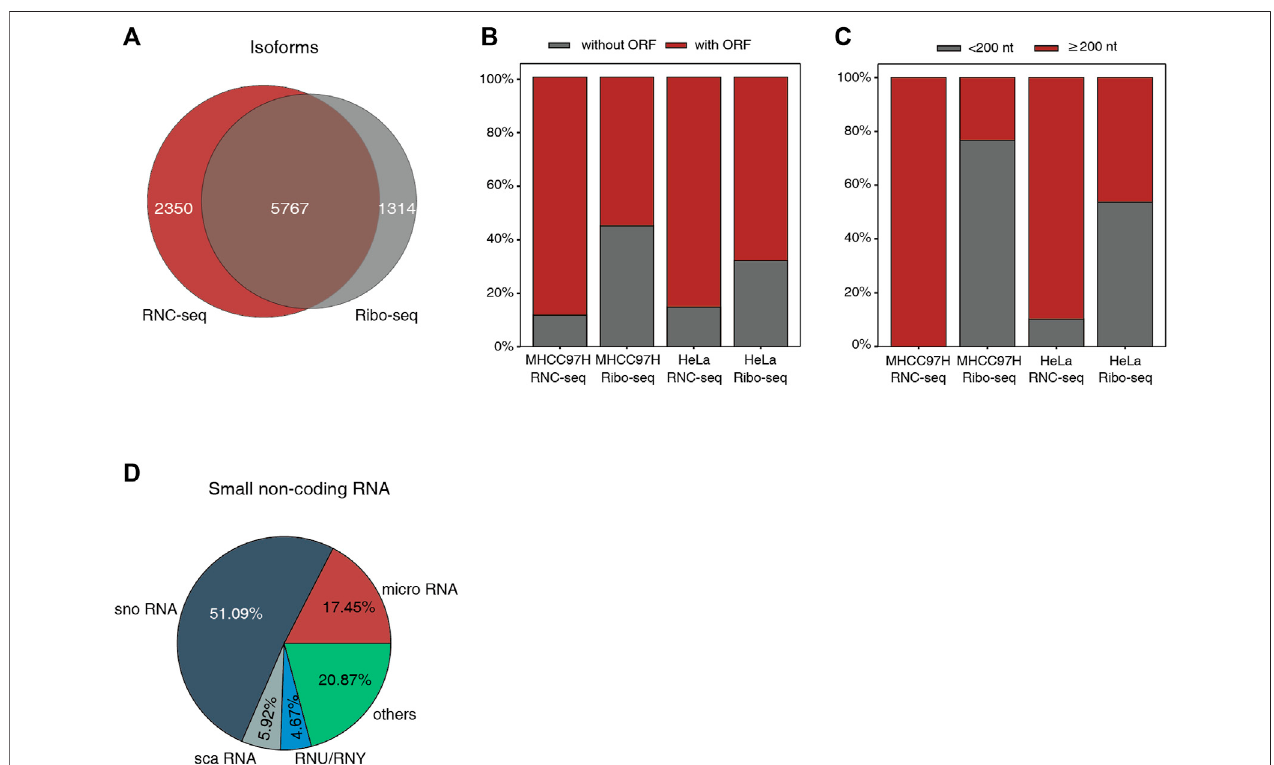
FIGURE2| Thedifferenceofidenti fi edisoformsbetweenRNC-seqandRibo-seq. (A) Venndiagramofisoformsidenti fi edbyRNC-seqandRibo-sequsing8million uniquelymappedreads,respectively. (B) Distributionofidenti fi edncRNAwithandwithoutORFs. (C) LengthdistributionofthencRNAwithoutcanonicalORF. (D) Types of small ncRNA identi fi ed by Ribo-seq of